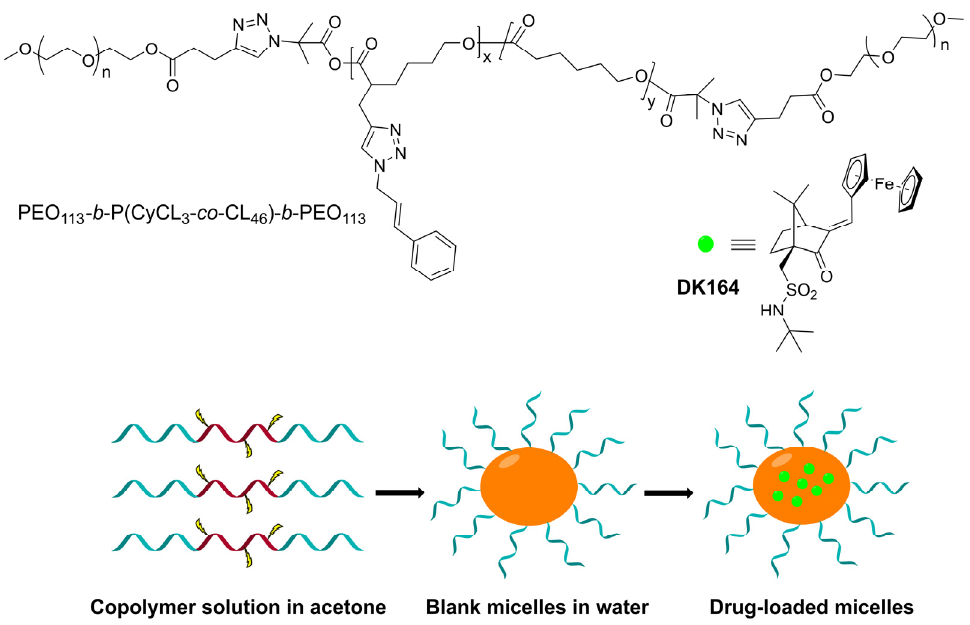
Figure 1. Preparation of DK164-loaded micellar nanoparticles based on PEO 113 - b -P(CyCL 3 - co -CL 46 )- b -PEO 113 amphiphilic triblock copolymer.